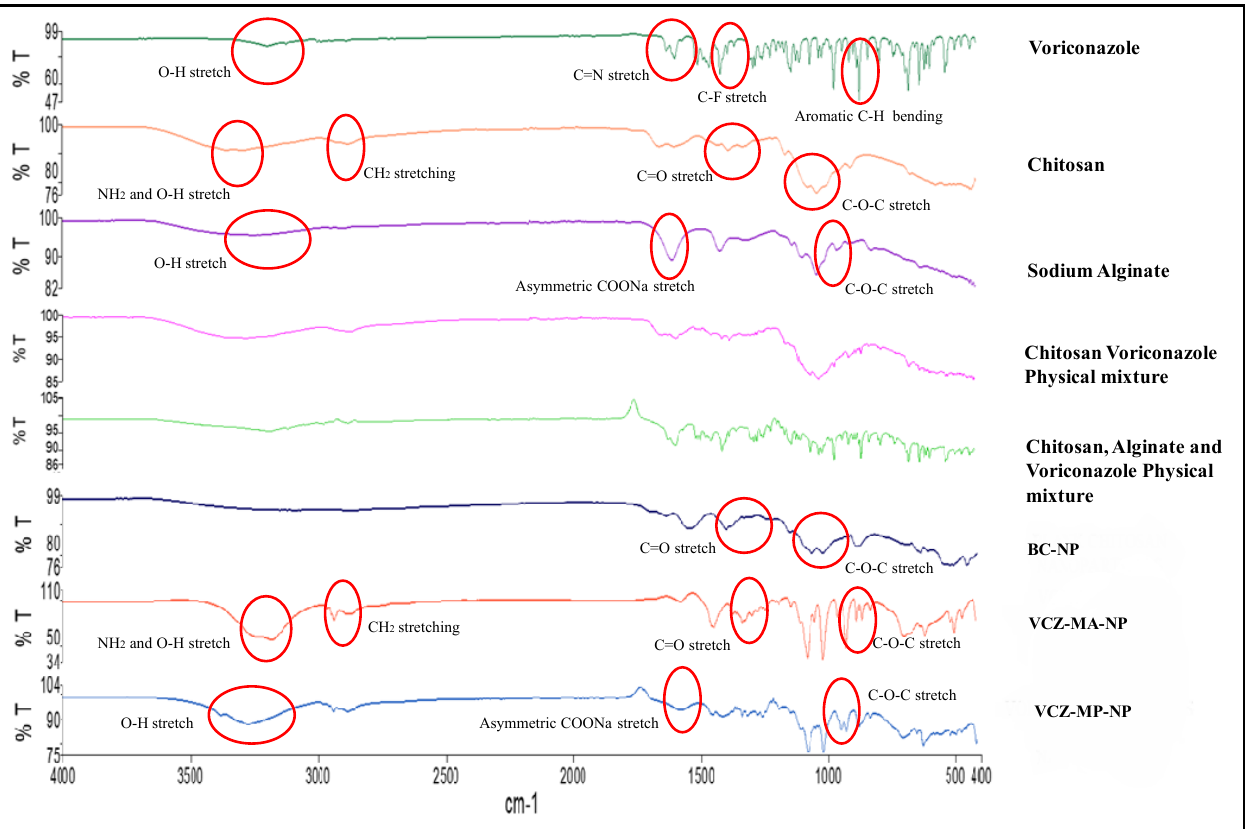
Figure 5. FT-IR spectra of voriconazole, chitosan, sodium alginate, physical mixture of drug and excipients, BC-NPs, VCZ-MA-NPs, and VCZ-MA-NPs (top to bottom). Characteristic peaks of VCZ disappeared in modified nanoparticles, while VCZ-MA-NPs, and VCZ-MP-NPs showed a similar pattern as chitosan and sodium alginate, respectively.